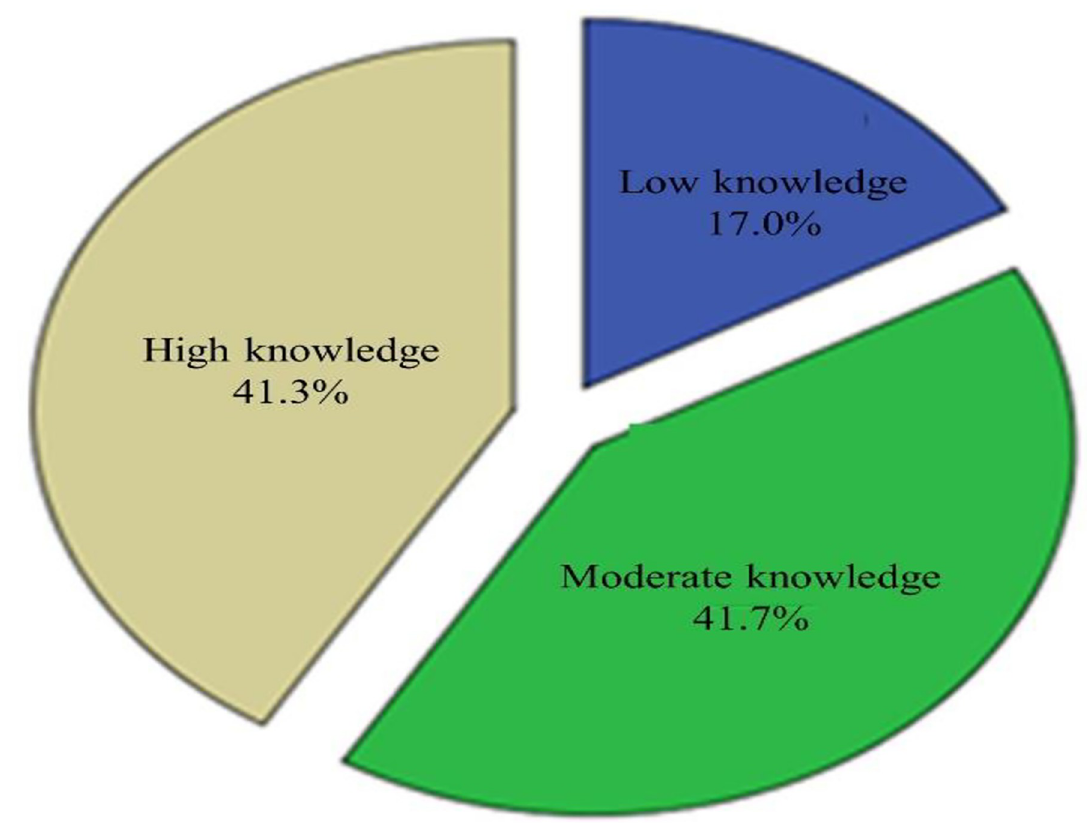
Fig 1. Pie chart indicating multi-dimensional knowledge status about COVID-19, Jimma-Ethiopia, March, 2020.